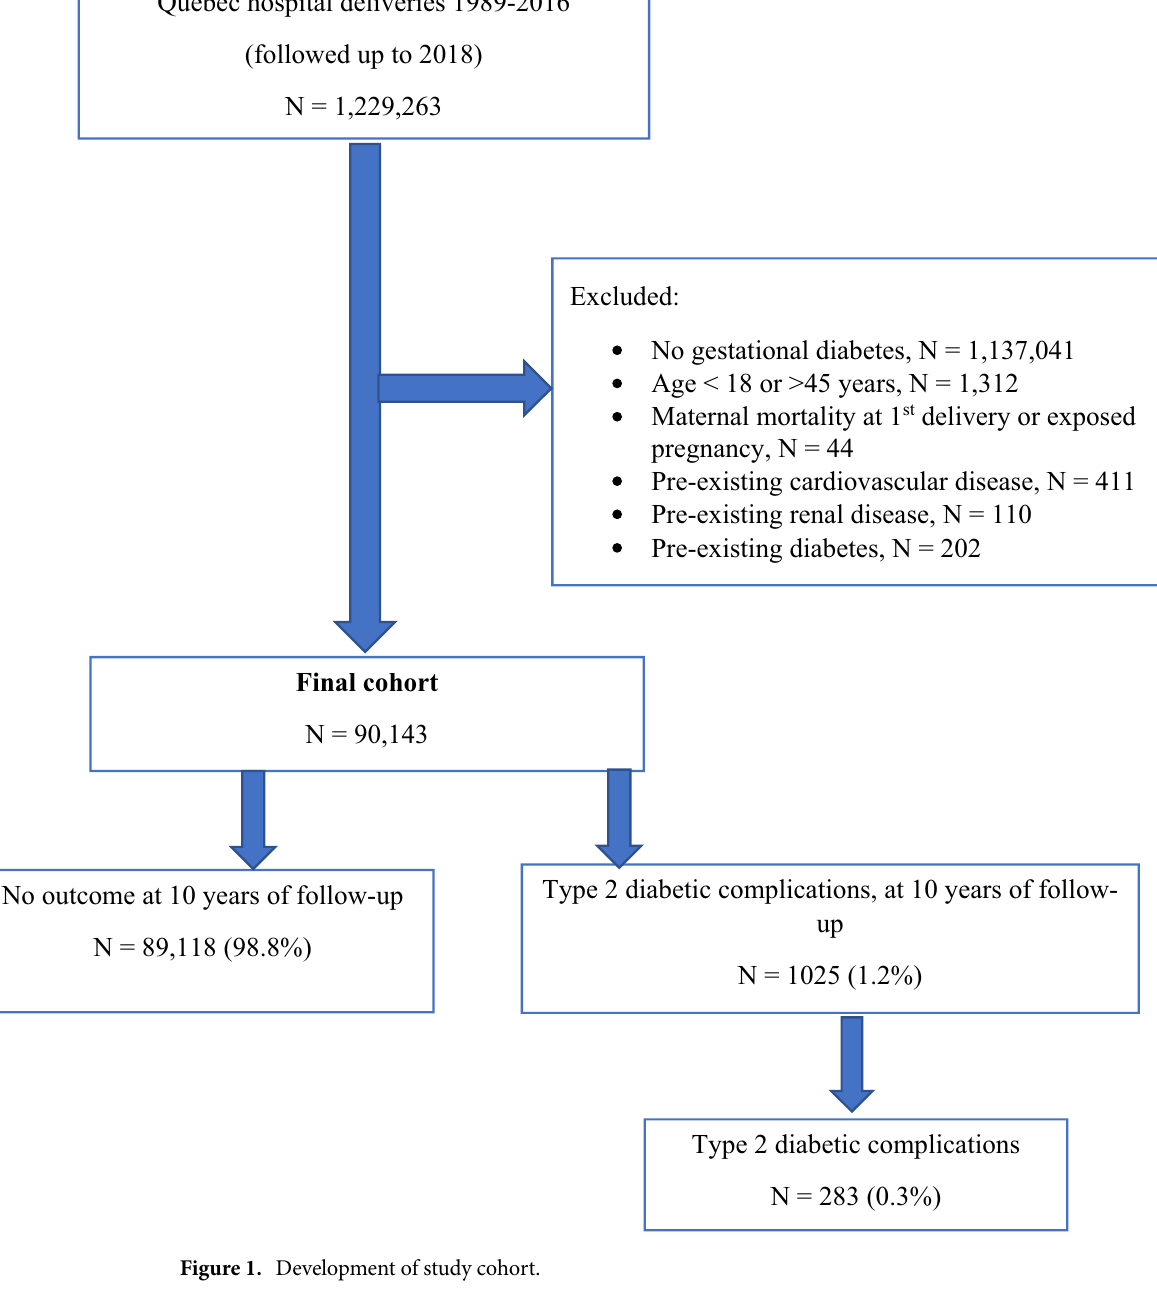
Figure 1. Development of study